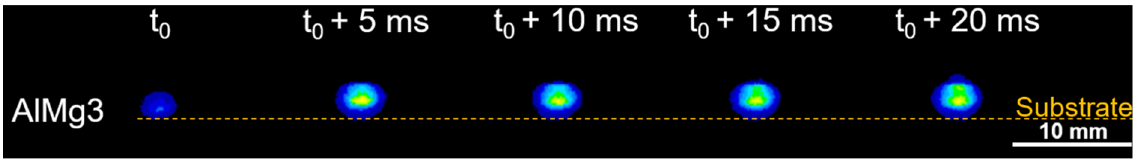
Figure 4. High-speed imaging camera images of hot vapor plume expansion during the laser welding of AlMg3. Figure 5a,b reveal the evolution of the hot vapor plume height in an interval of 27.5